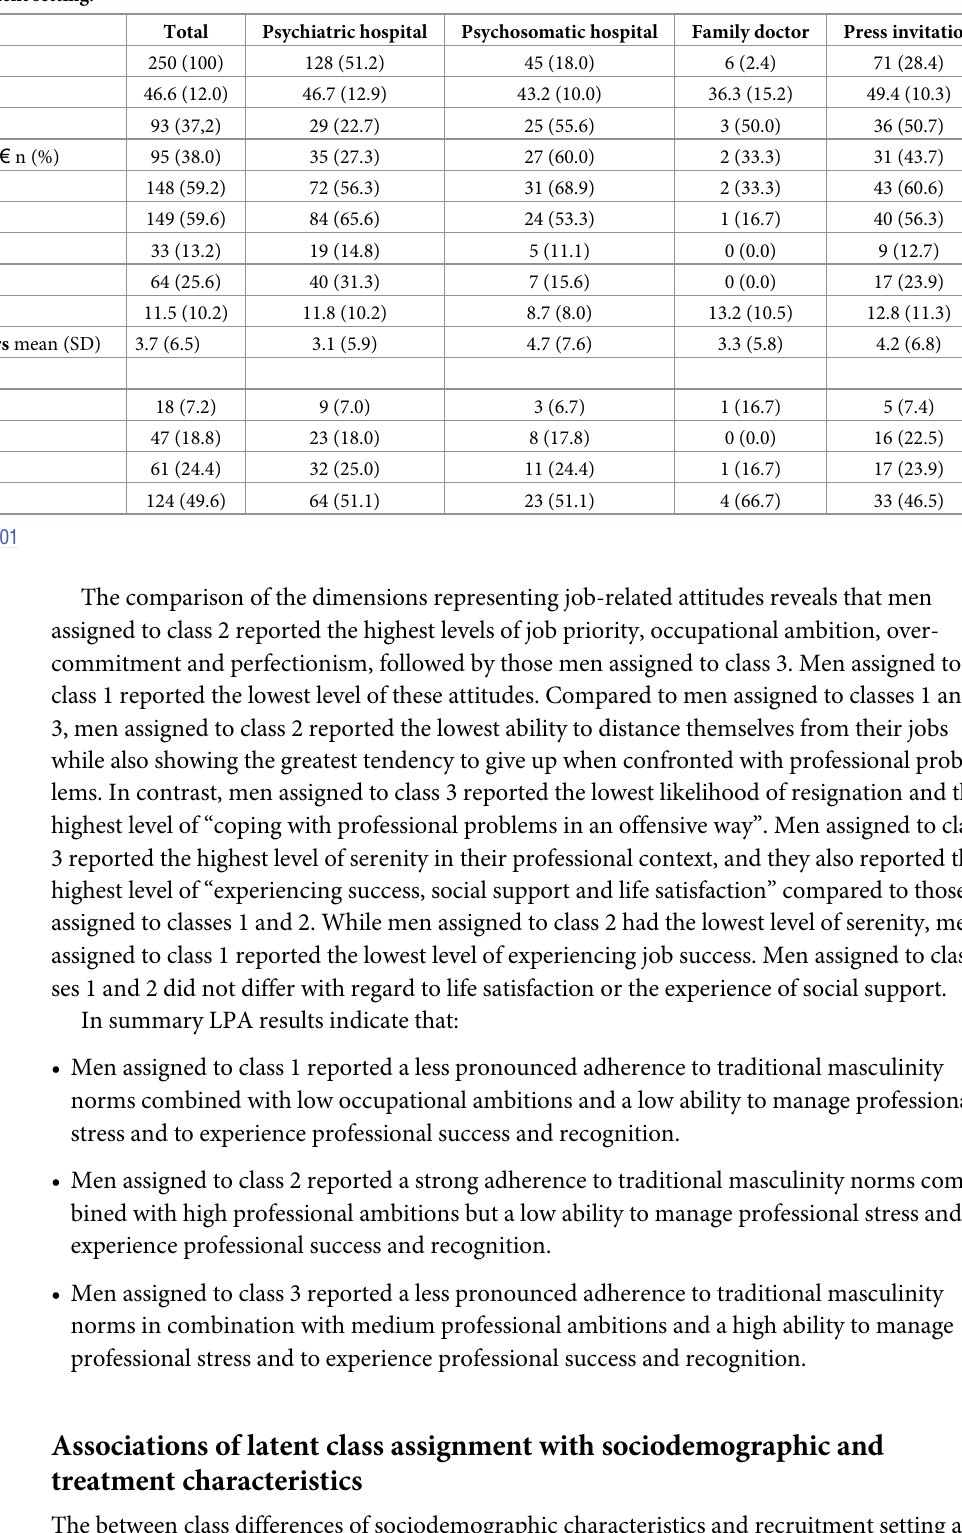
Table 1. Sample characteristics by recruitment